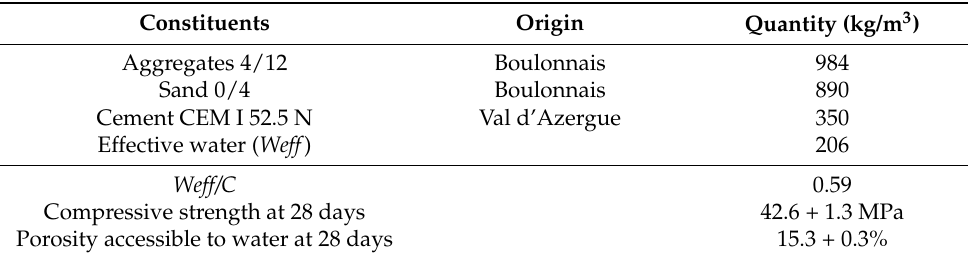
Table 1. Concrete mix design and characterization.